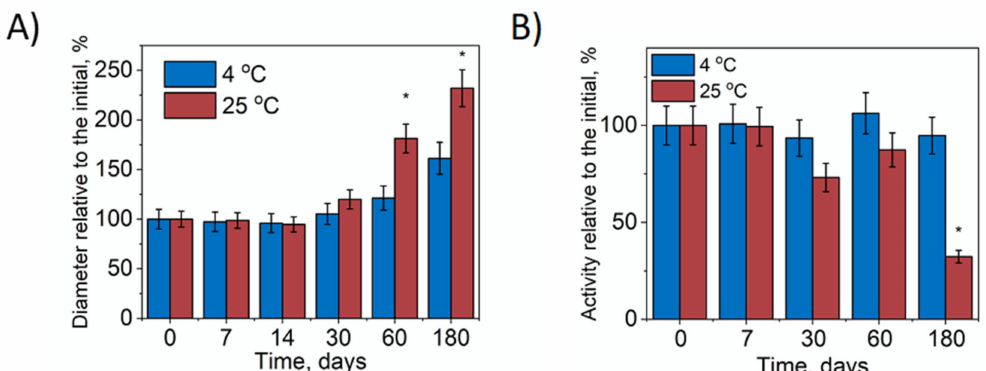
Figure 2. Stability of Nano-SOD1. ( A ) Relative change of Nano-SOD1’s hydrodynamic diameter during storage. ( B ) Relative change of SOD1 activity in Nano-SOD1 during storage. The PBS was used as a buffer solution. Data are mean ± SD ( n = 3); * p ≤ 0.05 (ANOVA). Statistical significance is shown relative to parameters at the initial